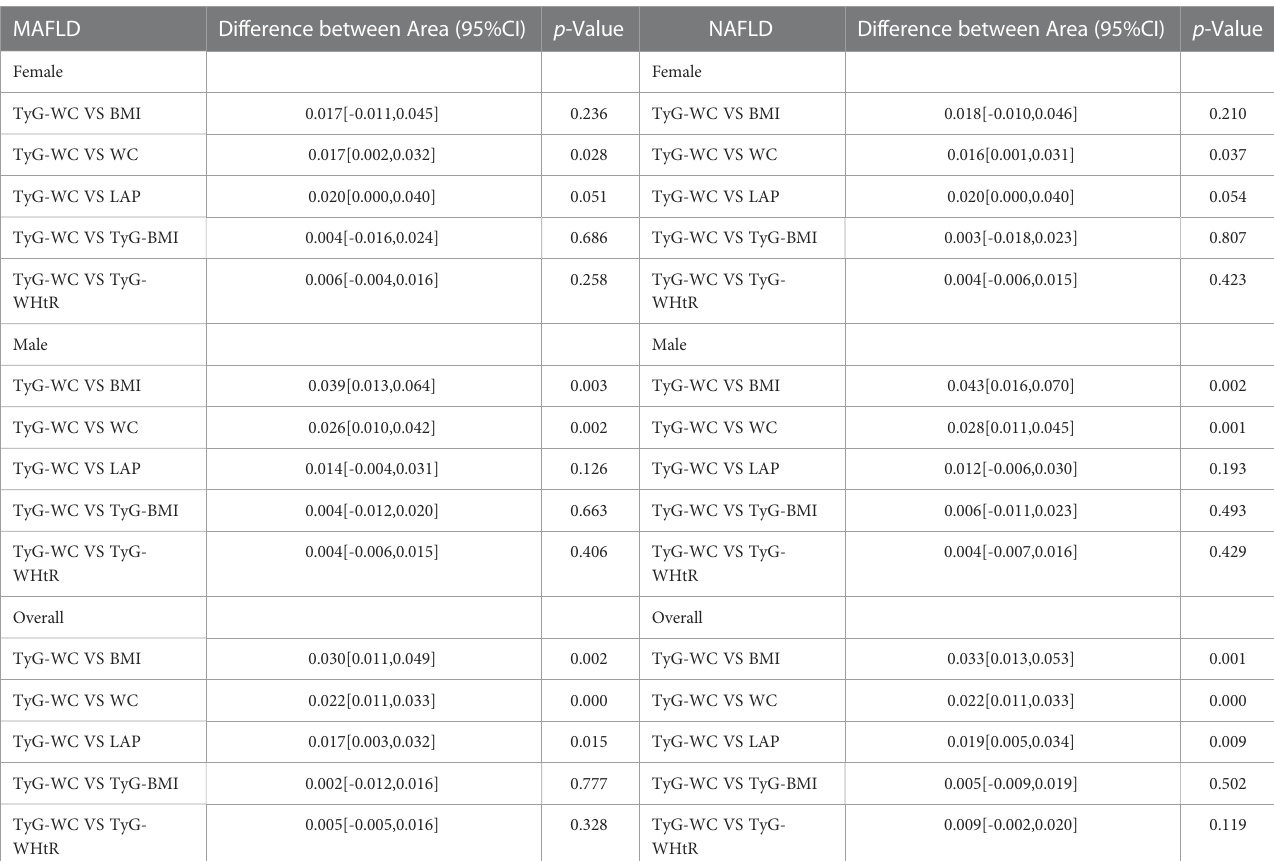
TABLE 4 Gender differences in AUC values between TyG-WC and other indexes.